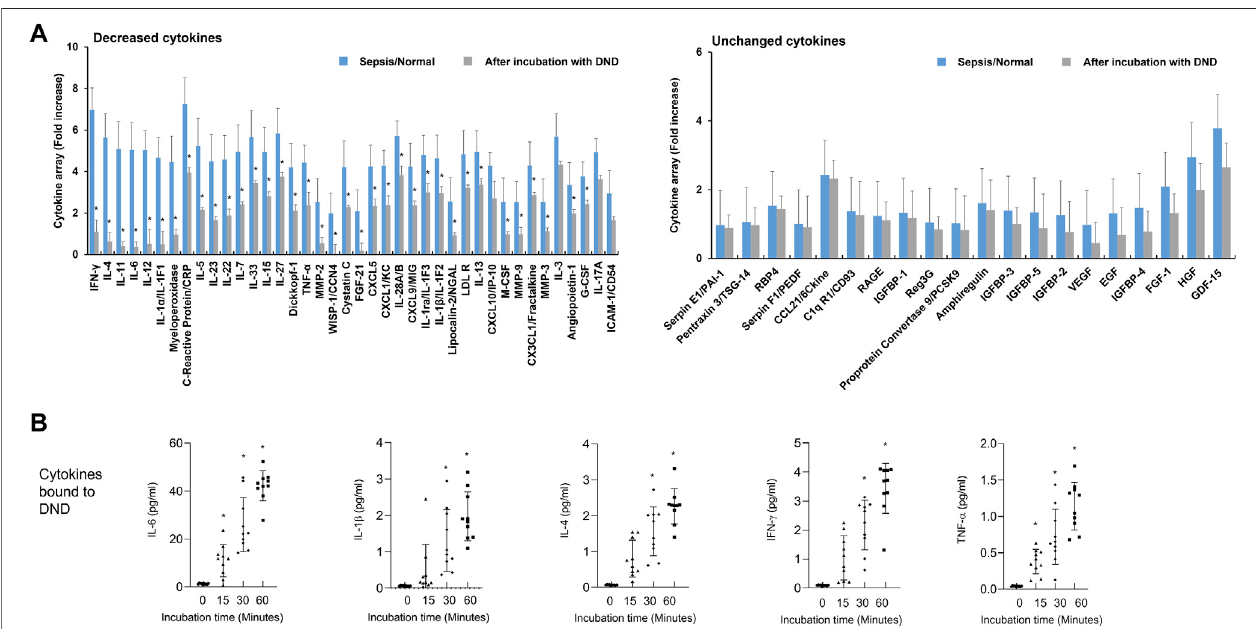
FIGURE3 | Highly puri fi ed DND ameliorates cytokine levels in theplasmaof sepsispatients( n = 10). (A) Cytokine array showing whichin fl ammatory mediators are adsorbed (left graph) or not (rightgraph) tothe DND from the proteome analysis. (B) The adsorption kineticsofDND withkey cytokines including IL-6, IL-1 β , IL-4, IFN- γ , and TNF- α in the plasma of patients with septic shock ( n = 10). Data are mean ± SEM with signi fi cance set at * p < 0.05 compared to the control group.